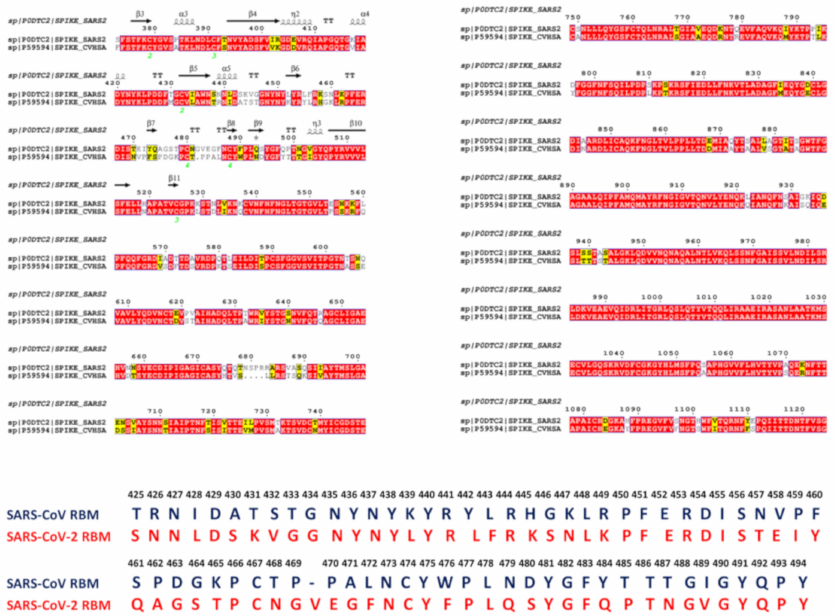
Figure 2. Sequence alignment of the SARS-CoV and SARS-CoV-2 RBD proteins. (Top panel) The sequence alignment of the SARS-CoV and SARS-CoV-2 spike proteins. (Bottom panel). The sequence comparison of the RBM residues. SARS-CoV-RBD residues are in blue and SARS-CoV-2 RBD residues are in red. The close-up of the RBM alignment highlights presence of evolutionary conserved positions even in the most variable interface region. The emergence of a significant number of amino acid modifications between the SARS-CoV and SARS-CoV-2 RBD proteins can be also